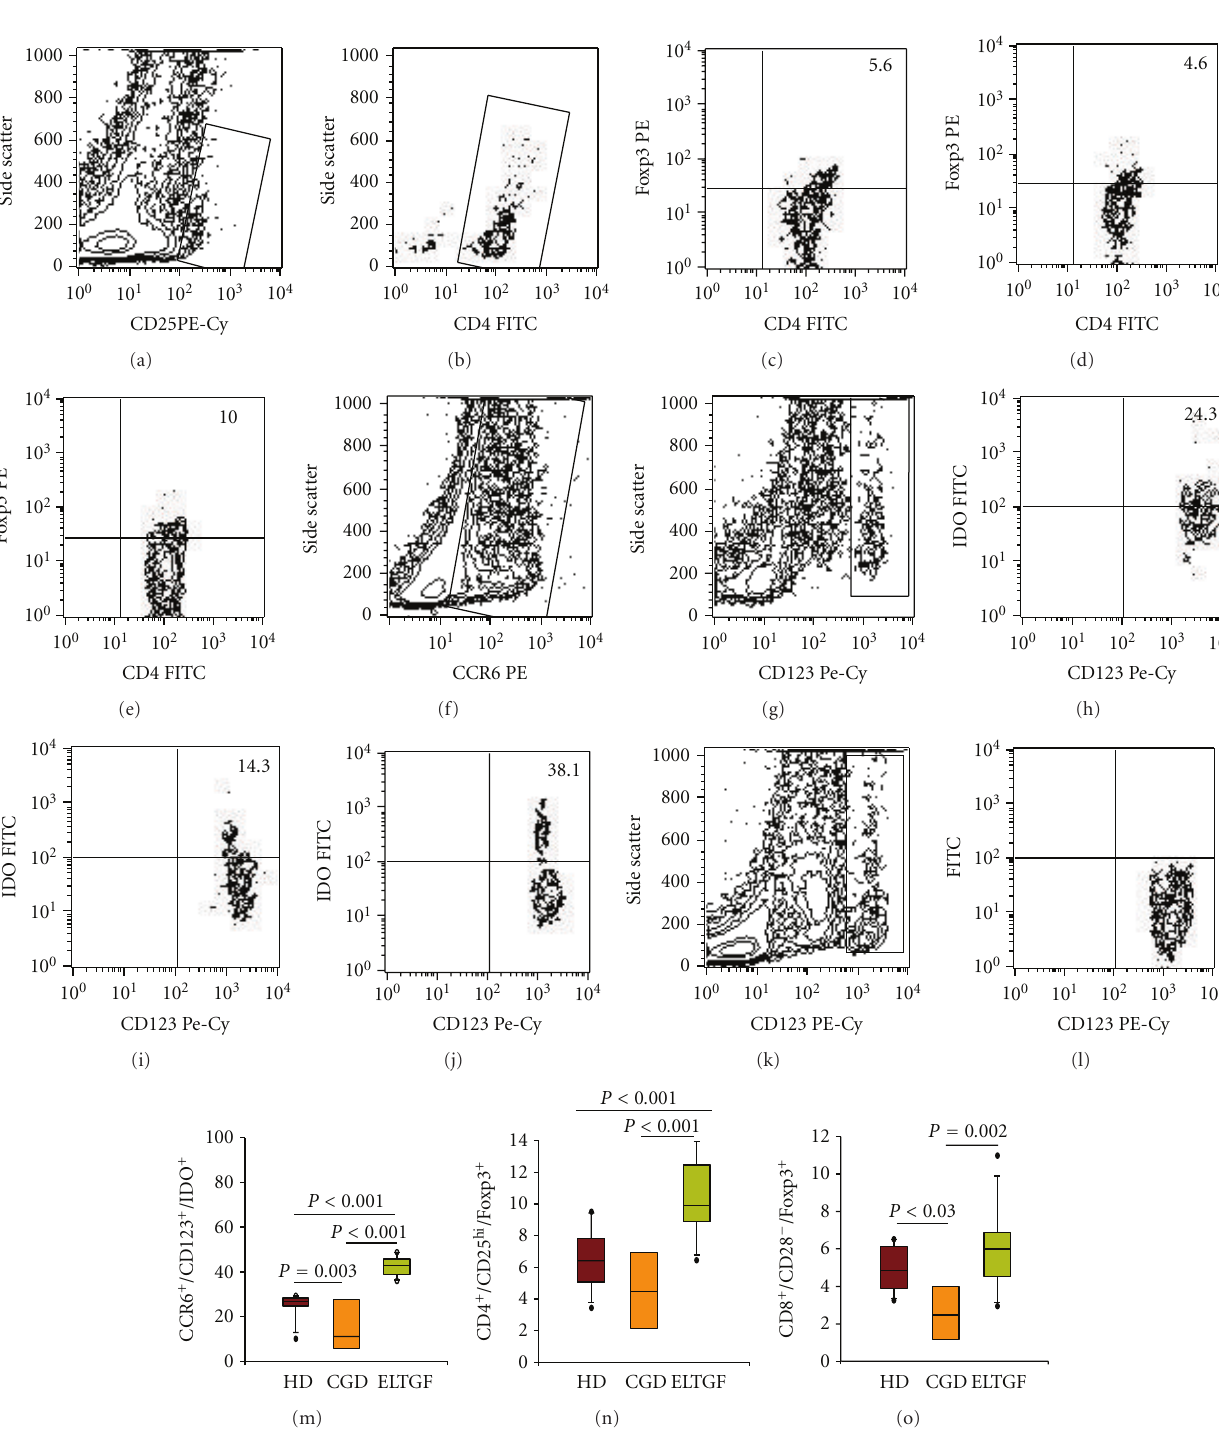
Figure 4: Percentage of IDO-and Foxp3-expressing peripheral blood cells in KTR. (a) Representative contour plot from a patient. An electronic gate was made for CD25 hi cells. (b) From the gate a , CD4 + /CD25 hi were determined, and an electronic gate was made for double positive cells. From the latter, CD4 + /CD25 hi /Foxp3 + cells were defined in (c) a healthy donor (HD), (d) a chronic graft dysfunction (CGD), and (k) an excellent long-term graft function under immunosuppression (ELTGF) patient. (f) An electronic gate was made for CCR6 + cells. (g) From the gate f , CCR6 + /CD123 + cells were determined, and an electronic gate was made for double positive cells. From the latter, CCR6 + /CD123 + /IDO + cells were defined in (h) a HD, (i) a CGD patient, and (j) an ELTGF patient. (k, l) Control of FITC-conjugated- rabbit antisheep specificity staining. Percentage of (m) CCR6 + /CD123 hi /IDO + , (n) CD4 + /CD25 hi /Foxp3 + , and (o) CD8 + /CD28 − /Foxp3 + peripheral blood cells. A total of 50,000 events were recorded for each sample before any gate setting and analyzed with the CellQuestPro software (BD Biosciences). Results are expressed as median, 10th, 25th, 75th, and 90th